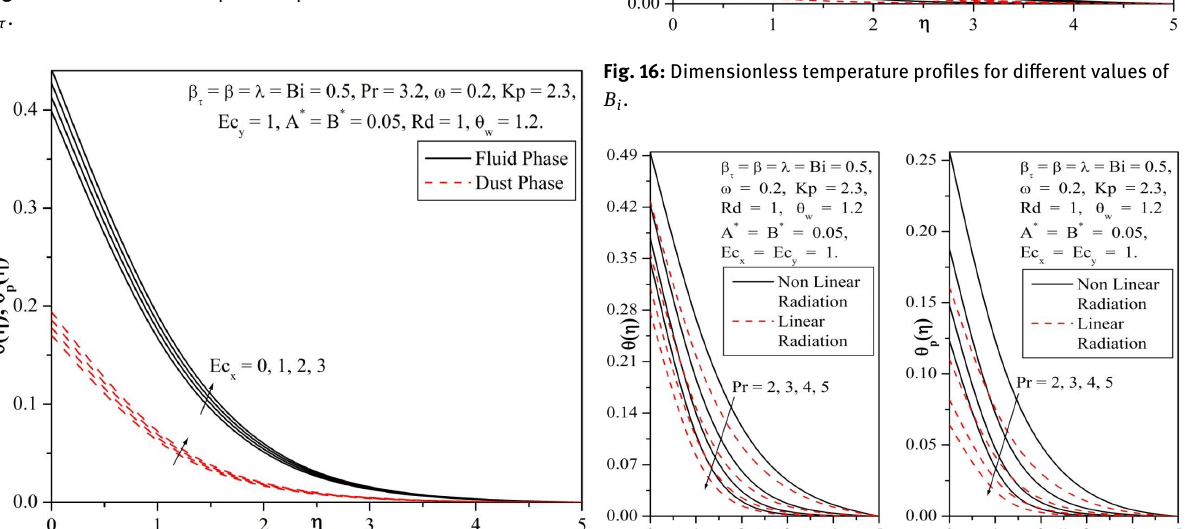
Fig. 17: Dimensionless temperature profiles for different values of Pr